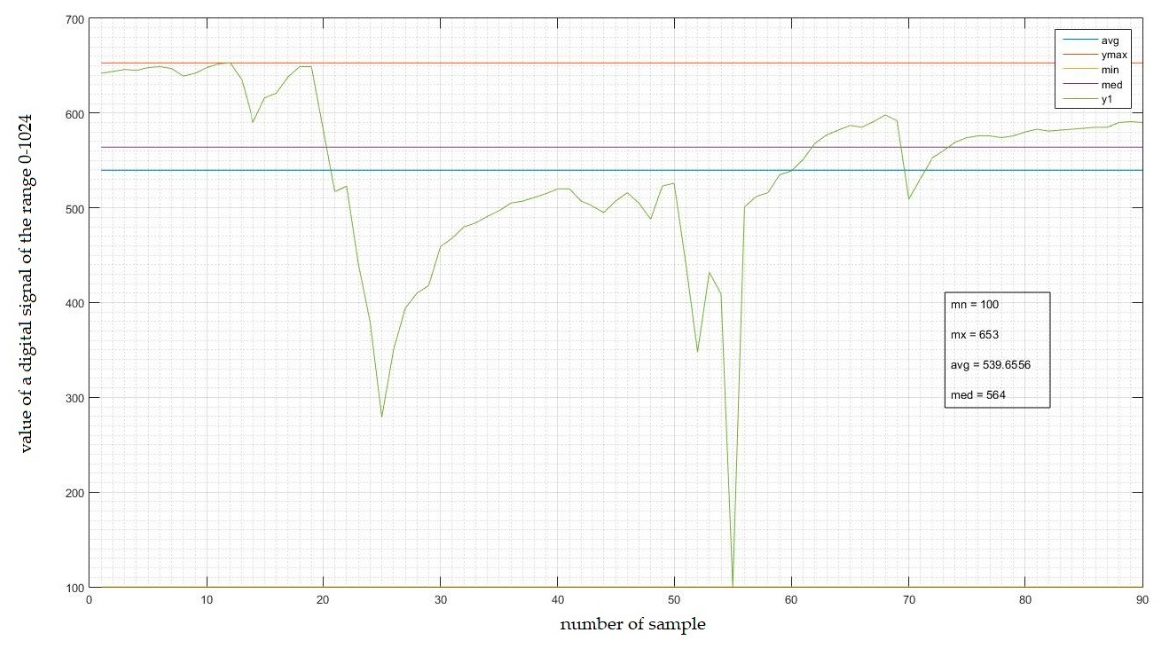
Figure A3. Data from the sensor on a maximally bent forefinger.